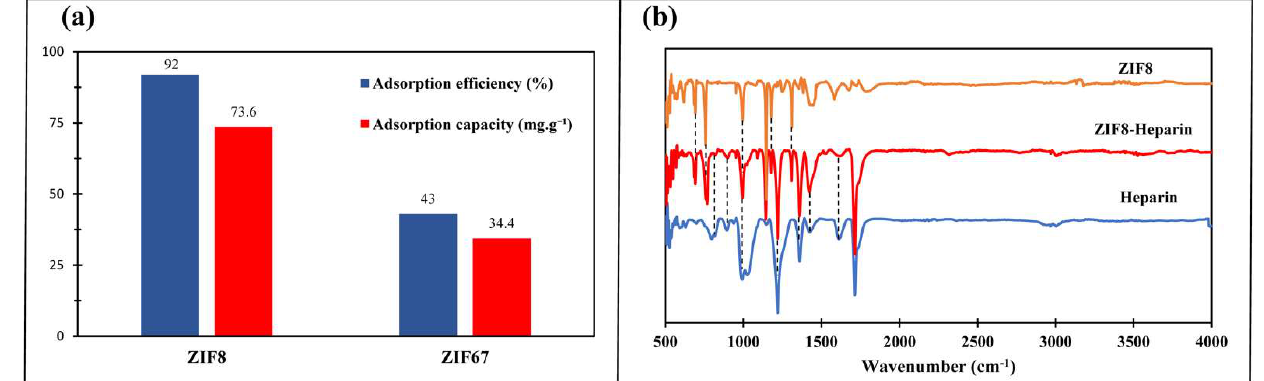
Figure 2. ( a ) Adsorption efficiency of heparin over ZIF-8 vs. ZIF-67 (conditions: 50 mL of 1000 mg L −1 heparin standard solution and 0.5 g of the adsorbent); ( b ) FTIR spectra of standard heparin, ZIF-8, and preabsorbed heparin on the ZIF-8.